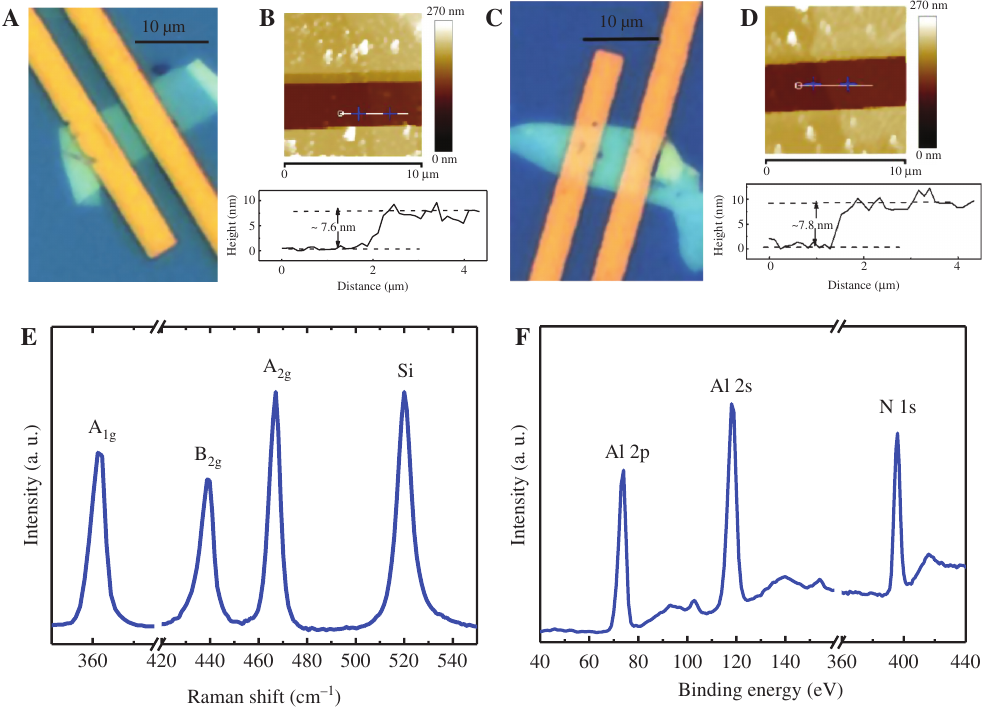
Figure 1: The AFM, Raman and XPS characterizations of the fabricated BP devices. Optical microscope image of fabricated devices on (A) AlN/SiO the extracted thickness of BP channel for devices on (B) AlN/SiO phosphorus as exfoliated; one out-of-plane mode (A of atomic-layer-deposited AlN